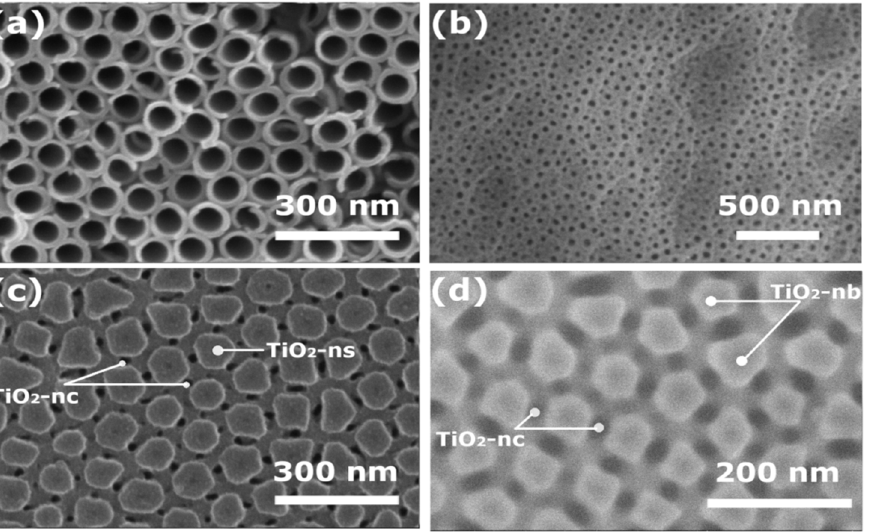
Figure 2. FE-SEM image of the surface of: ( a ) TiO 2 -nt; ( b ) TiO 2 -nc; ( c ) TiO 2 -ns assembled on TiO 2 -nc; and ( d ) TiO 2 -nb assembled on TiO 2 -nc synthesized by electrochemical anodization.